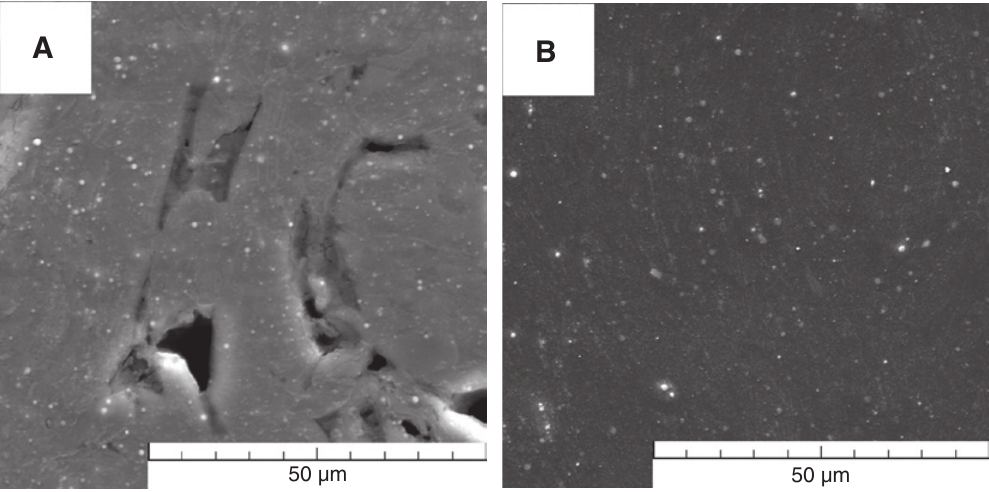
Figure 6: Mg-5HA prepared by mixing in planetary mill and (A) SPS at 400 ° C and (B) SPS at 500 °